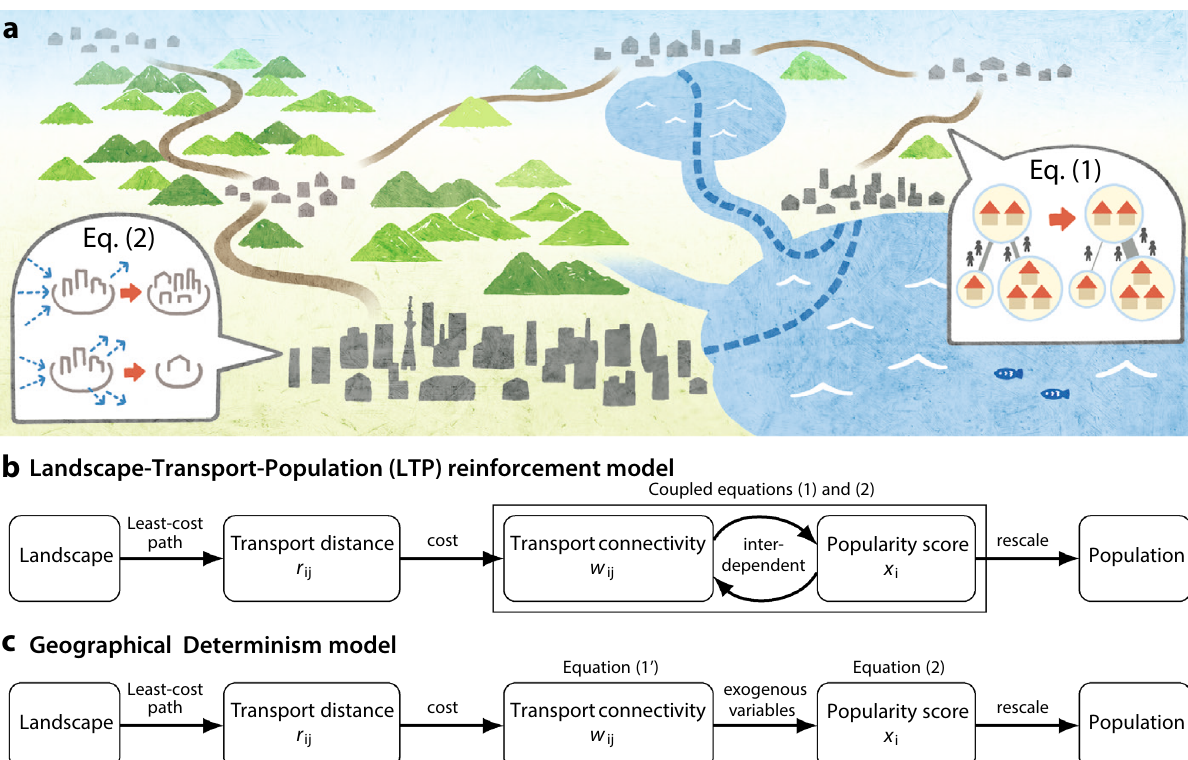
Figure 1. ( a ) Schematic illustration of dynamical pattern formation in the LTP-reinforcement model where populated places and their inter-connections emerge naturally across the landscape. Transport links following least-cost paths across the landscape are strengthened between locations with large populations, whilst well- connected centres in turn tend to grow to a greater extent. ( b,c ) Schematic diagram of the LPT-reinforcement model ( b ) and a counterfactual, ’Geographical Determinism’ model with no reinforcement of the transport network ( c